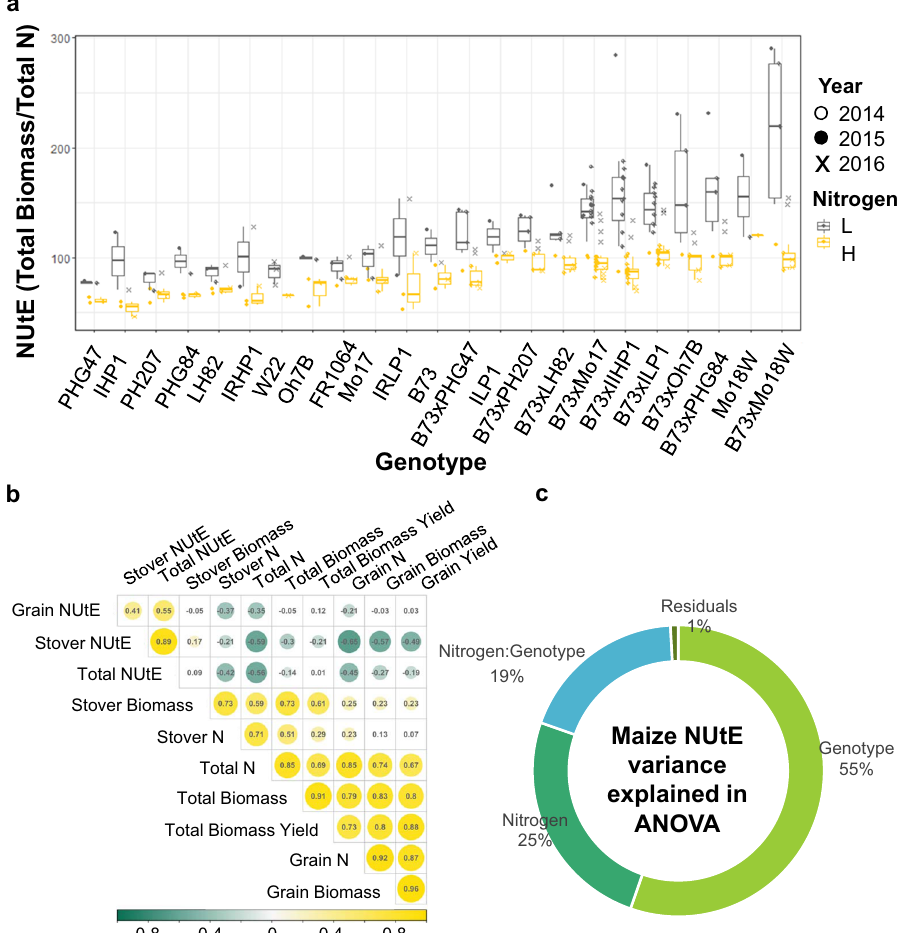
Fig. 3 Genotype is the leading factor explaining the NUE variation in maize breeding lines. a Boxplot of total nitrogen utilization (NUtE) values among the maize genotype panel measured in three consecutive years. The X -axis is ordered by increasing value of average total NUtE. The coef fi cients of variation demonstrate the broad range of phenotype of this smaller panel of maize genotypes, which spans the distribution of NutE values measured in a larger representative germplasm collection (Supplementary Fig. 2). In the box plots, the box represents the 25th to 75th percentile and the line within the box marks the median. Whiskers above and below the box indicate the 10th and 90th percentiles. Points above and below the whisers indicate outliers outside 10th and 90th percentiles. b The correlation of traits measured in this study.c The total NUtE variance of 2014, the year when the RNA samples were harvested, is primarily explained by Genotype ( G ), followed by N , and G × N effect. Two-way ANOVA P -value: G , 8.6E − 11; N , 2.9E − 13; G × N , 2.28E − 07. For each genotype n > 5 biologically independent plants examined over three independent experiments. The source data for this fi gure is provided